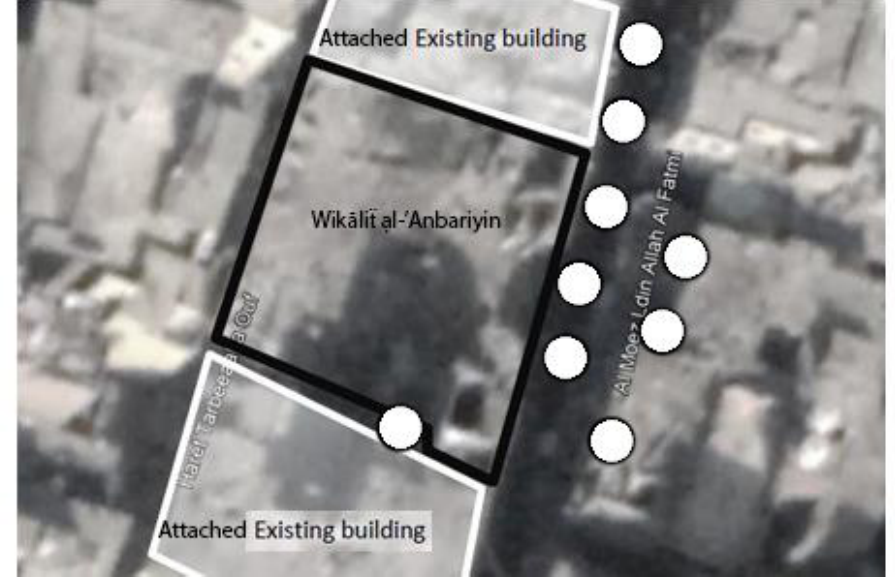
Figure 9. The location of the interviewees, in the surrounding of Wikāliẗ ạl - ’Anbariyin. (Source: Google Earth Pro. (October 12, 2018). Wikāliẗ ạl - ’Anbariyin , Cairo. 30° 02'49.02" N, 31° 15'36.42" E, Eye alt 100m. DigitalGlobe 2019. http://www.earth.google.com [May